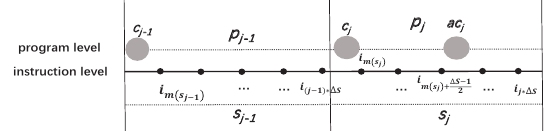
Figure 10. An example of adding a